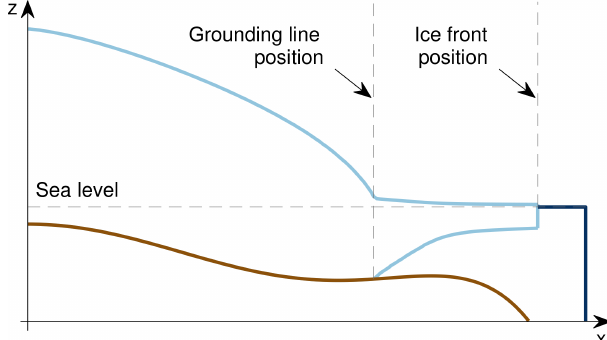
Figure 1. Vertical cross-section of a marine ice sheet: marine ice sheet (light blue), ocean (dark blue) and bedrock (brown). The po- sition of the grounding line is implicitly defined by the level set function, φ gl , based on a hydrostatic floatation criterion (Seroussi et al.,